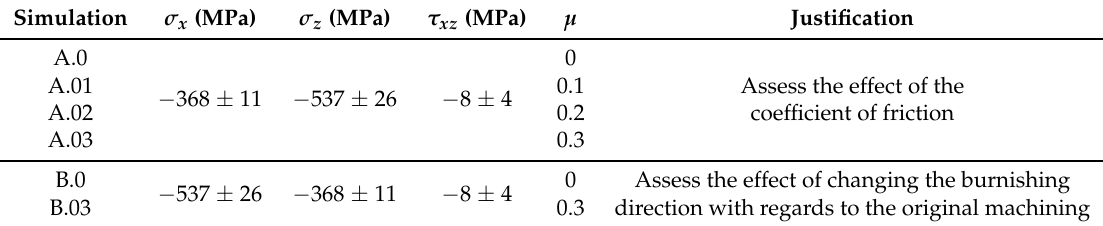
Table 4. Six FEM scenarios and justification regarding the reason to include them in the study.